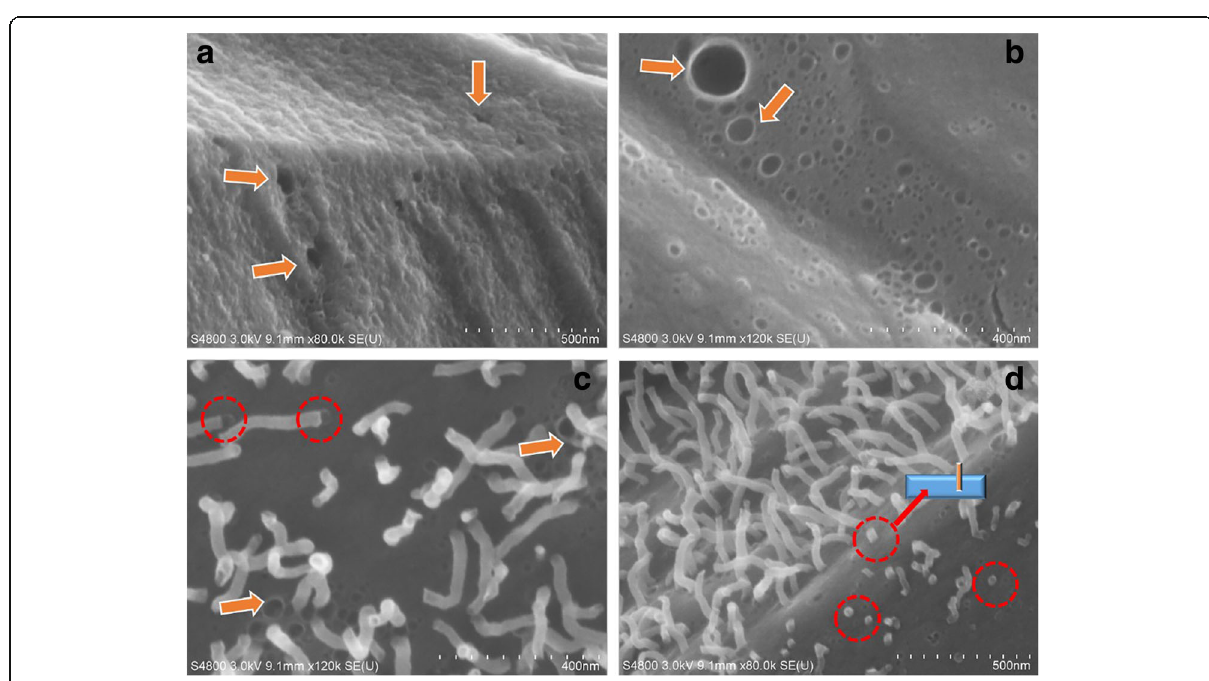
Fig. 3 FESEM image s of the cross-section of the VF ( a × 80 k) and the surface of the pure ACF ( b × 120 k) and Ag nanohair-grown ACF ( c × 120 k, d × 120 k)